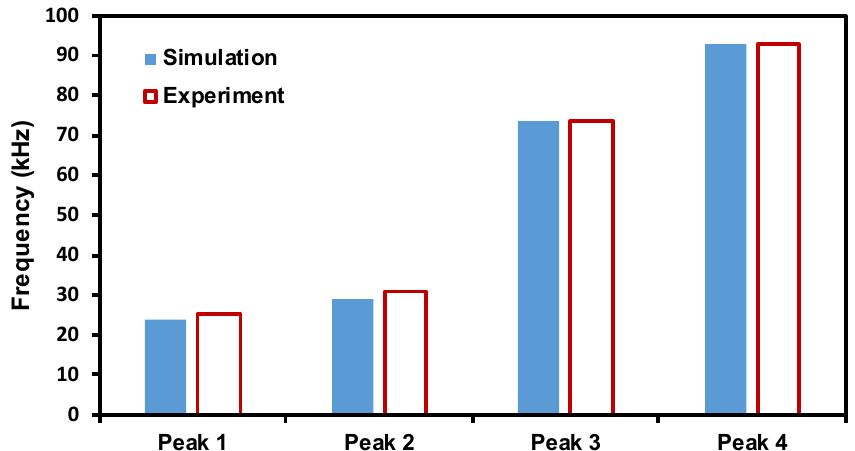
Figure 6. Comparison of peak frequencies between the numerical simulation and the experiment.